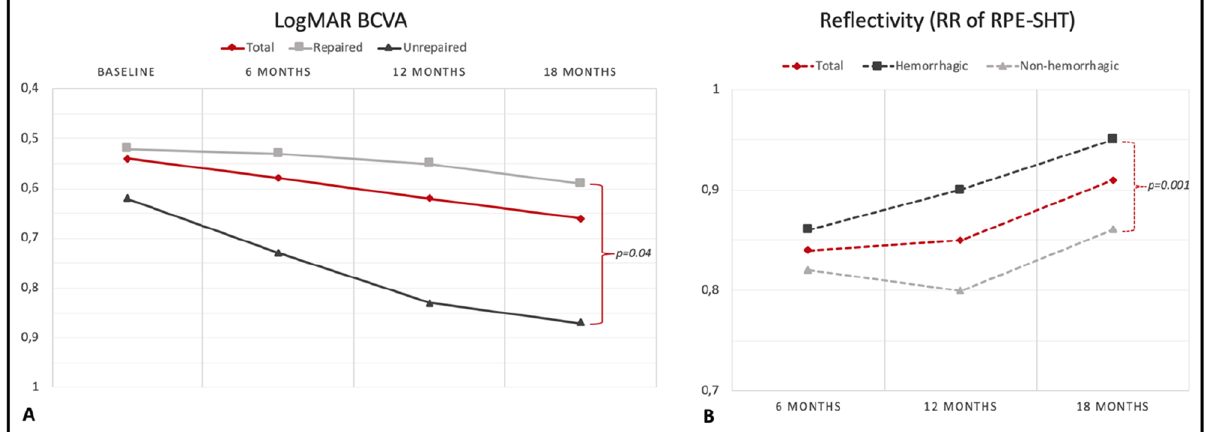
Figure 3. Variation of the best-corrected visual acuity (BCVA) and of the relative reflectivity (RR) of the repair tissue over the follow-up. ( A ) shows the visual acuity changes occurring in time; BCVA appears to deteriorate remarkably in patients that did not have signs of repair tissue formation ( p = 0.04). The reflectivity of the repair tissue ( B ) increases in time during the follow-up particularly in patients with hemorrhagic tears at baseline ( p = 0.001).